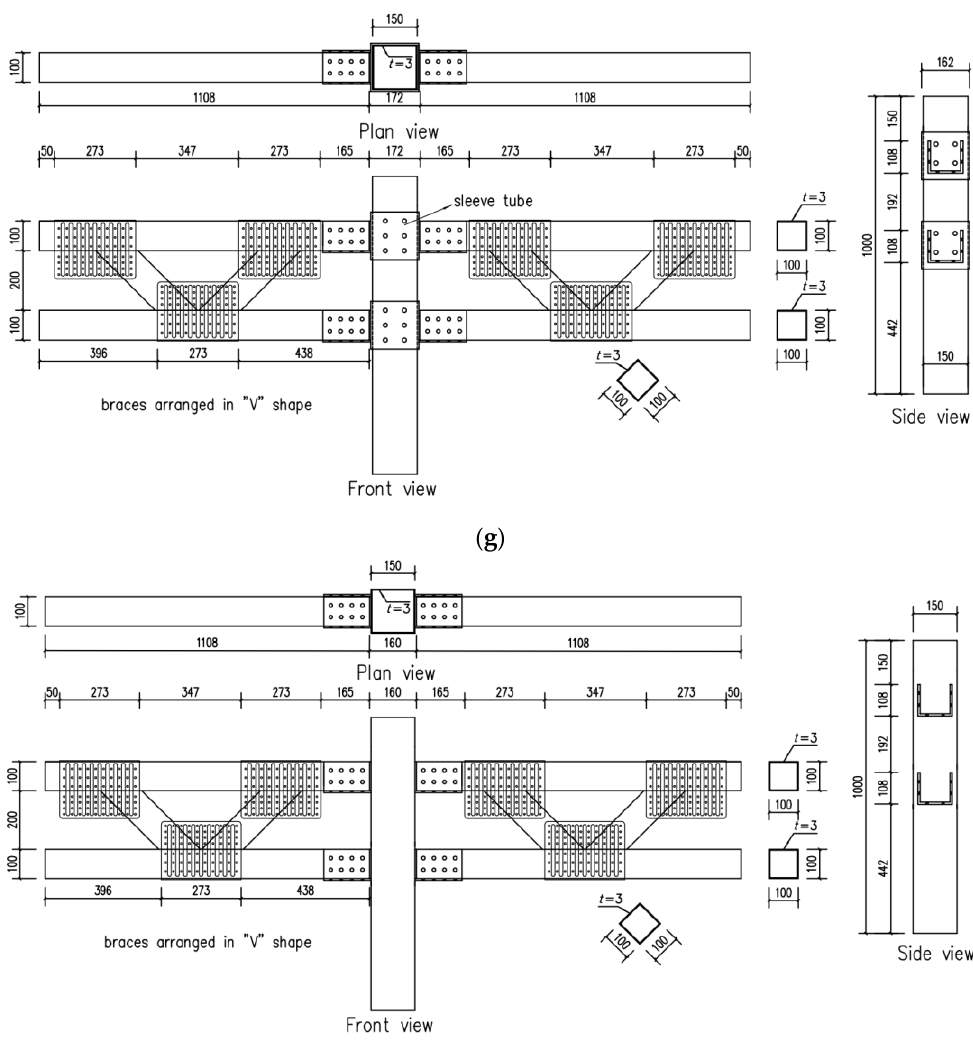
Figure 2. Numbering, configuration, and dimensions of eight specimens. ( a ) JU60 − 1, ( b ) JU60 − 2, ( c ) JU60 − 3, ( d ) JU60 − 4, ( e ) JU100 − 1, ( f ) JU100 − 2, ( g ) JU100 − 3, ( h ) JU100 − 4.